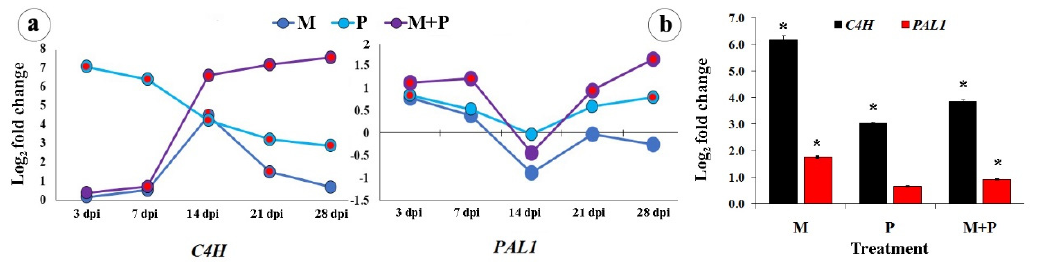
Figure 2. Change in the transcriptional expression levels of the phenylpropanoid biosynthetic pathway genes in sunflower leaves at 3, 7, 14, 21, and 28 dpi ( a ), and roots at 28 dpi ( b ) in response to colonization with R. irregularis and/or infection with R. solani . Where, M = colonized with R. irregularis , P = infected with R. solani , and M+P = colonized with R. irregularis and infected with R. solani . For each gene in the subfigure ( a ), treatments marked with red are significantly different at p ≤ 0.05. In the subfigure ( b ), bars indicate the standard error, and for each gene, columns superscripted with asterisks are significantly different at p ≤ 0.05.